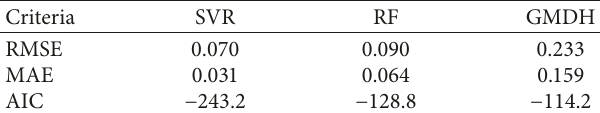
Table 6: The values of the error metrics. Criteria SVR RF GMDH